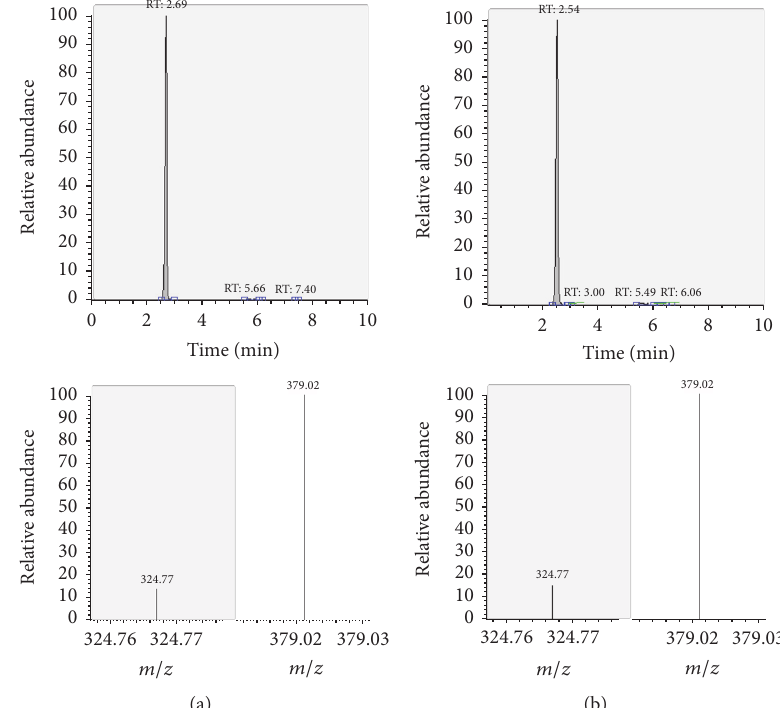
Figure 8: LC-MS/MS chromatograms of FLM and SRM transitions and relative abundances. (a) Standard in a 100 𝜇 gL −1 solution. (b) Standard in the spiked sample at 100mg kg −1 .